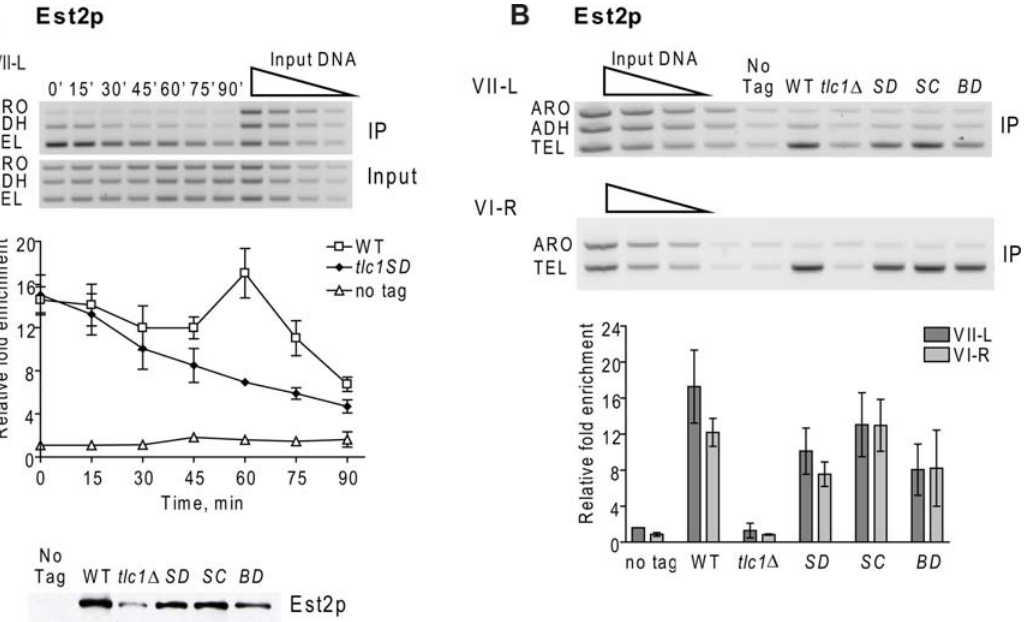
Figure 4. Est2p telomere binding in late S/G2 phase is reduced in mutants that lack the stem-bulge region of telomerase RNA. Methods are the same as in Figure 1 legend. A. Est2p binding to VII-L telomere in synchronous tlc1-SD (black diamonds) versus WT (white squares), or untagged (white triangles) cells. Est2p binding to the VII-L telomere was significantly lower in tlc1-SD than in WT cells late in the cell cycle (from 45 to 90 min, P values ranged from P=0.0007 at 60 min to 0.018 at 90 min). B. Est2p binding to VII-L (top) or VI-R (bottom) telomeres in asynchronous WT and mutant cells. Bar graphs show average Est2p association with telomere VII-L (dark grey) or VI-R (light grey) with error bars indicating 6 one standard deviation from that average; abbreviations for strains are SD, tlc1-SD ; SC, tlc1-SC ; and BD, tlc1-BD . The level of Est2p telomere binding in tlc1- SD cells was significantly lower than in WT (P=0.004, VII-L; 0.0003, VI-R) as well as at the VII-L telomere in tlc1-BD cells (P=0.001). The level of Est2p telomere binding in WT and tlc1-SC cells was not significantly different (P=0.083, VII-L; 0.573, VI-R). C. Western analysis of Est2p-G8-Myc in extracts from WT and mutant strains. Abbreviations for strains are same as in panel B.